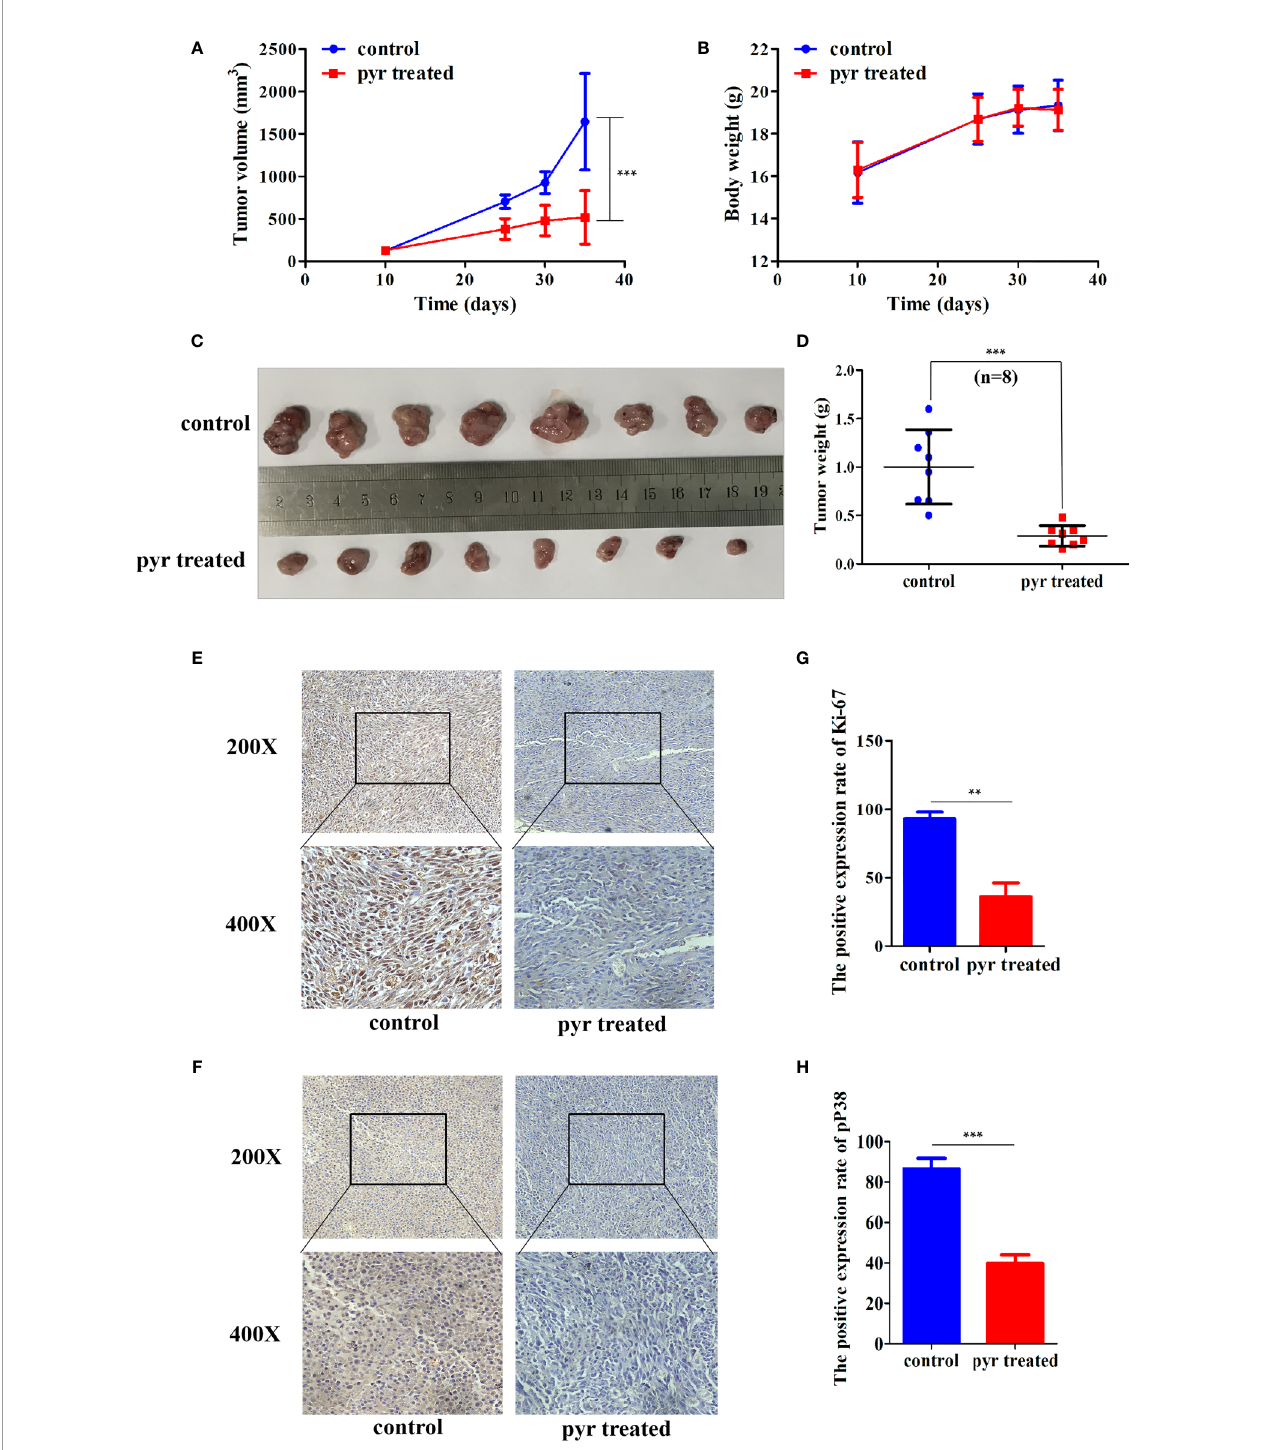
FIGURE 3 | Pyrimethamine affects tumorigenesis of PC3 cells in vivo . (A) Tumor volumes were measured on the indicated days and drew into the tumor growth curves. (B) The body weight of each mouse was monitored during the experiment. (C) Image of tumors dissected from 16 nude mice (n = 8 for each group). 6 × 10 6 PC3 cells were implanted subcutaneously into the right armpit regions of each nude mouse. After injection 10 days (~120 mm 3 ), mice were randomly distributed into two groups, pyrimethamine treated group (15 mg/kg/d) and the control group. (D) The tumors' weight were weighed and presented by scatter plot. (E, F) Representative immunohistochemistry staining images of Ki-67 and P38 from tumor tissues in each group. (G, H) Mean positive rates ± SD were shown (n = 8). Data represent the mean ± SD of three independent experiments. ** P < 0.01 ; *** P < 0.001 ( vs.